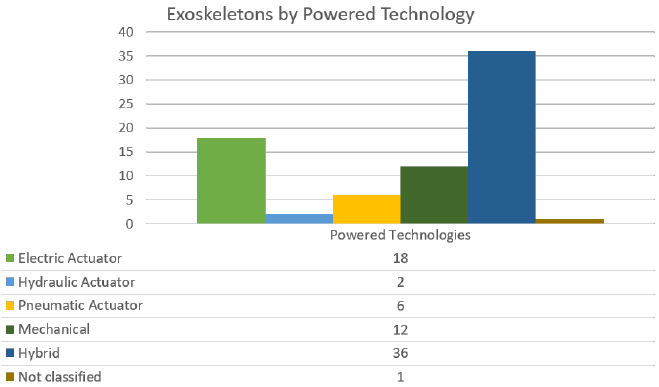
Figure 8. This plot portrays the classification of exoskeletons by the technology used to power the